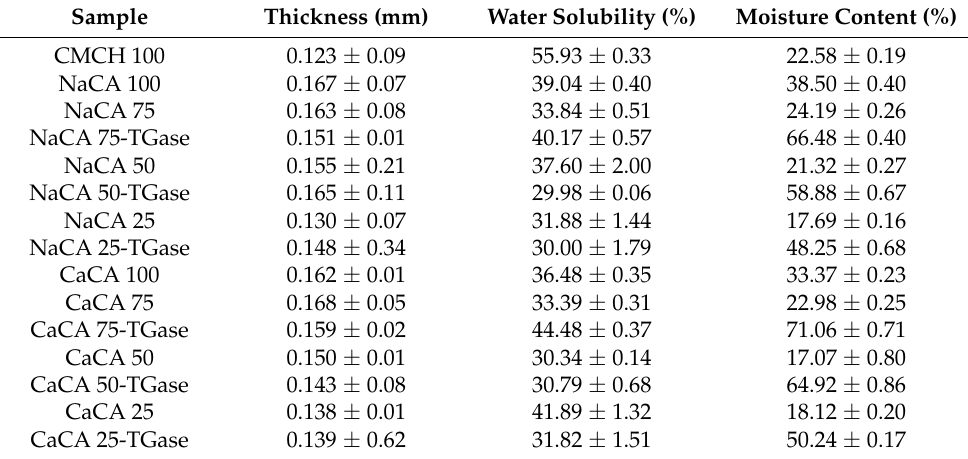
Table 1. Nomenclature and physicochemical properties of edible